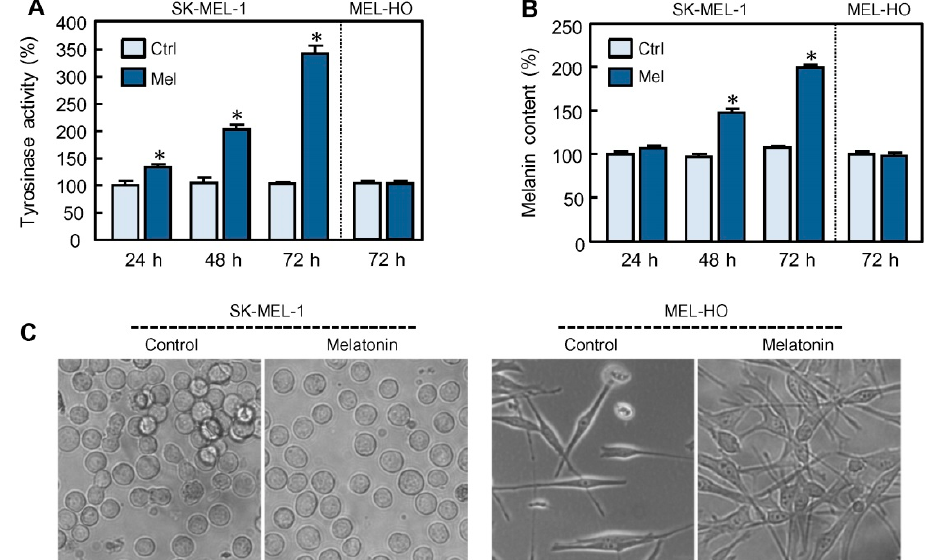
Figure 1. Effect of melatonin on melanogenesis in human melanoma cells SK-MEL-1 and MEL-HO. The cells were cultured in presence of 1 mM melatonin (Mel) for the time period indicated and tyrosinase activity ( A ) and melanin content ( B ) were determined and expressed as percentage of control. ( C ) The cells were cultured in presence of 1 mM melatonin for 72 h and visualized under phase contrast microscopy; original magnification 20×. * p < 0.05 vs. control (Ctrl).